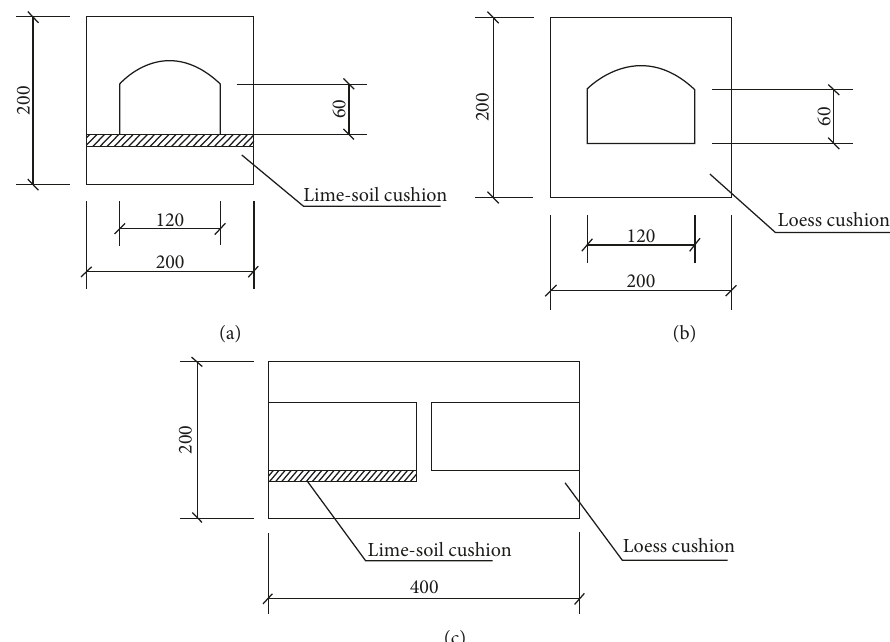
Figure 8: Front elevation (a), back elevation (b), and a longitudinal cross section (c) of the cave dwelling model (unit of dimensions: mm).